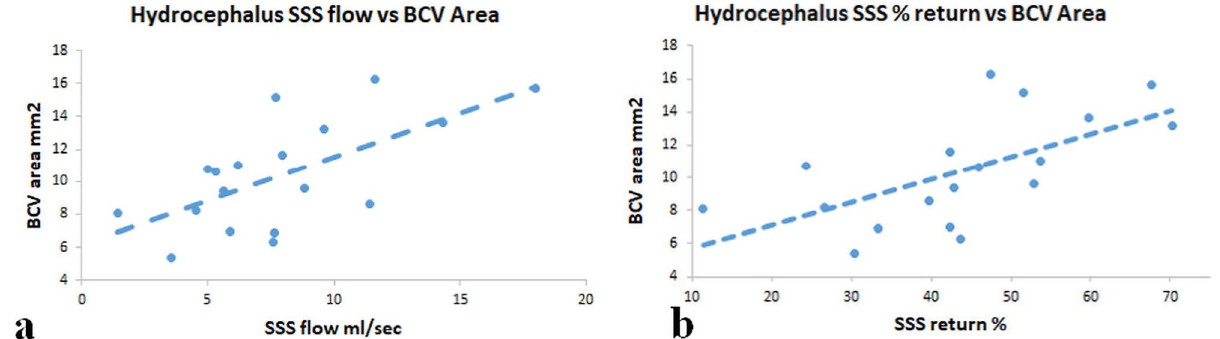
Figure 2. Scatter plots of significant correlations. ( a ) A scatter plot of hydrocephalus superior sinus flow vs bridging cortical vein area showing a positive correlation (r = 0.65, p = 0.004). ( b ) A scatter plot of hydrocephalus superior sagittal sinus percent return vs bridging cortical vein area showing a positive correlation (r = 0.67, p =